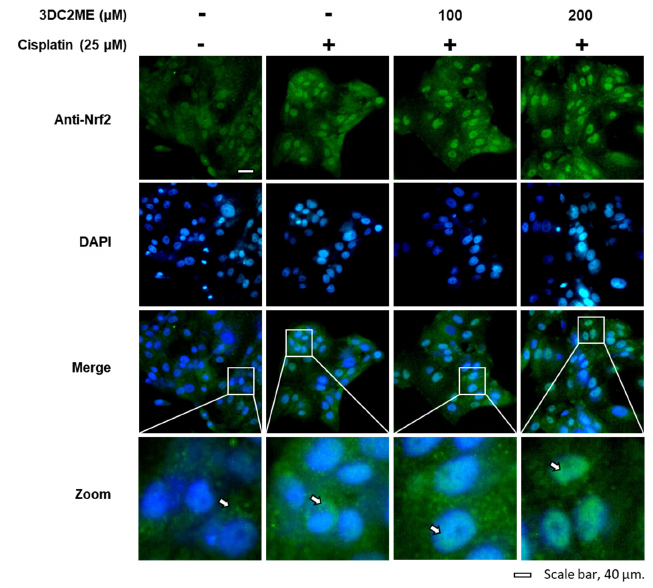
Figure 4. Effects of 3DC2ME and/or cisplatin on nuclear translocation of Nrf2 in LLC-PK1 cells. LLC-PK1 cells were exposed to 25 μ M cisplatin in the presence or absence of 100 or 200 μ M 3DC2ME, and immunofluorescent staining was performed using antibodies for Nrf2 that were vis- ualized with a goat anti-rabbit IgG-heavy and light chain antibody FITC conjugate (green) and mounted with ProLong ® Gold antifade reagent with DAPI stained nucleus (DAPI). Representative images were visualized using an IX50 fluorescent microscope. The white arrows indicate the pres- ence of Nrf2 (scale bar = 40 μ m).